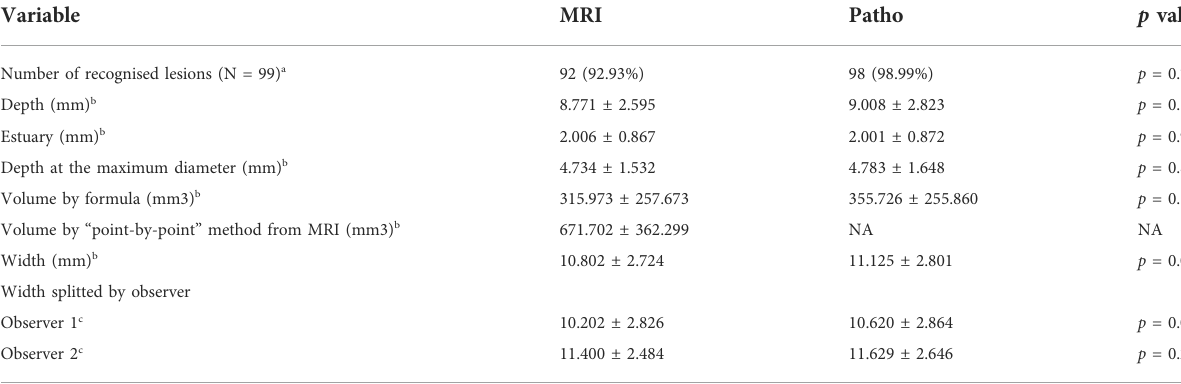
TABLE 1 Comparison of evaluation of radiofrequency lesions with gross pathology inspection (patho) and MRI evaluation. Variable MRI Patho p value